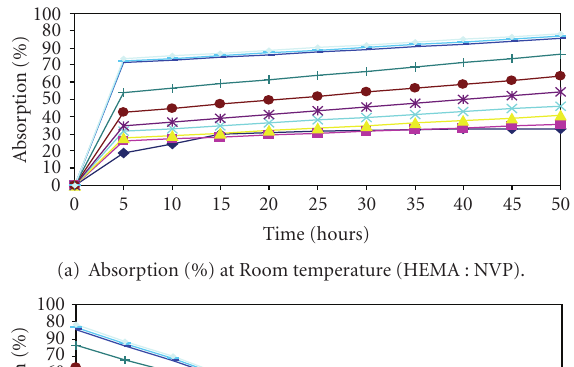
is carried out at ambient conditions, this would be a pre- ferred option for polymerization compared to conventional methods like thermal